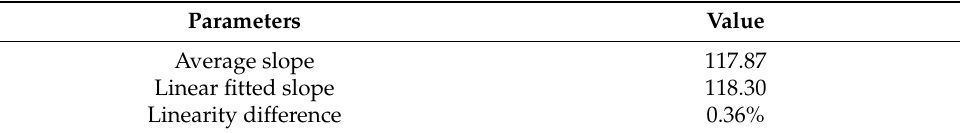
Table 2. Response linearity of IRFPA for the range − 20~10 °C. Figure 7. Response slope of IRFPA.